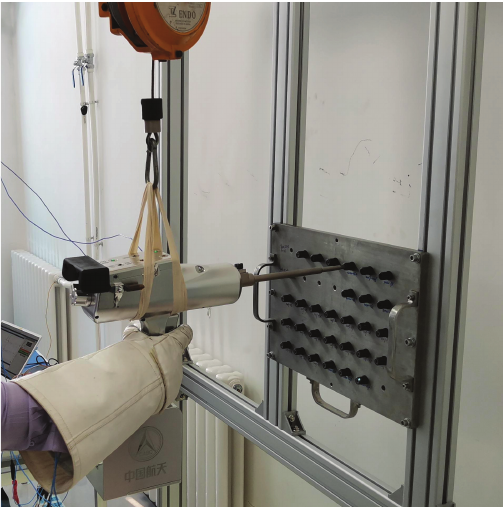
Figure 4. The typical subject operating test with spacesuit